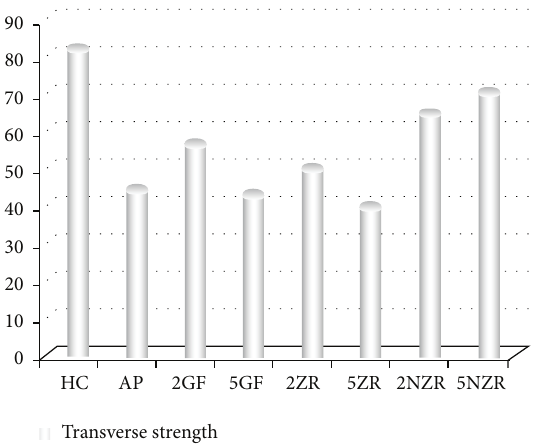
Figure 2: Mean value of transverse strength for all tested